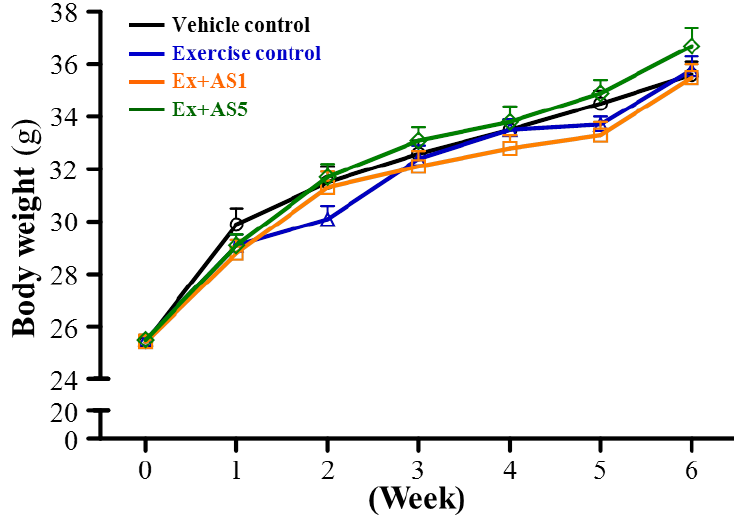
Figure 1. Effect of AS supplementation on the changes of body weight. Data are mean ± SEM for n = 10 mice per group.